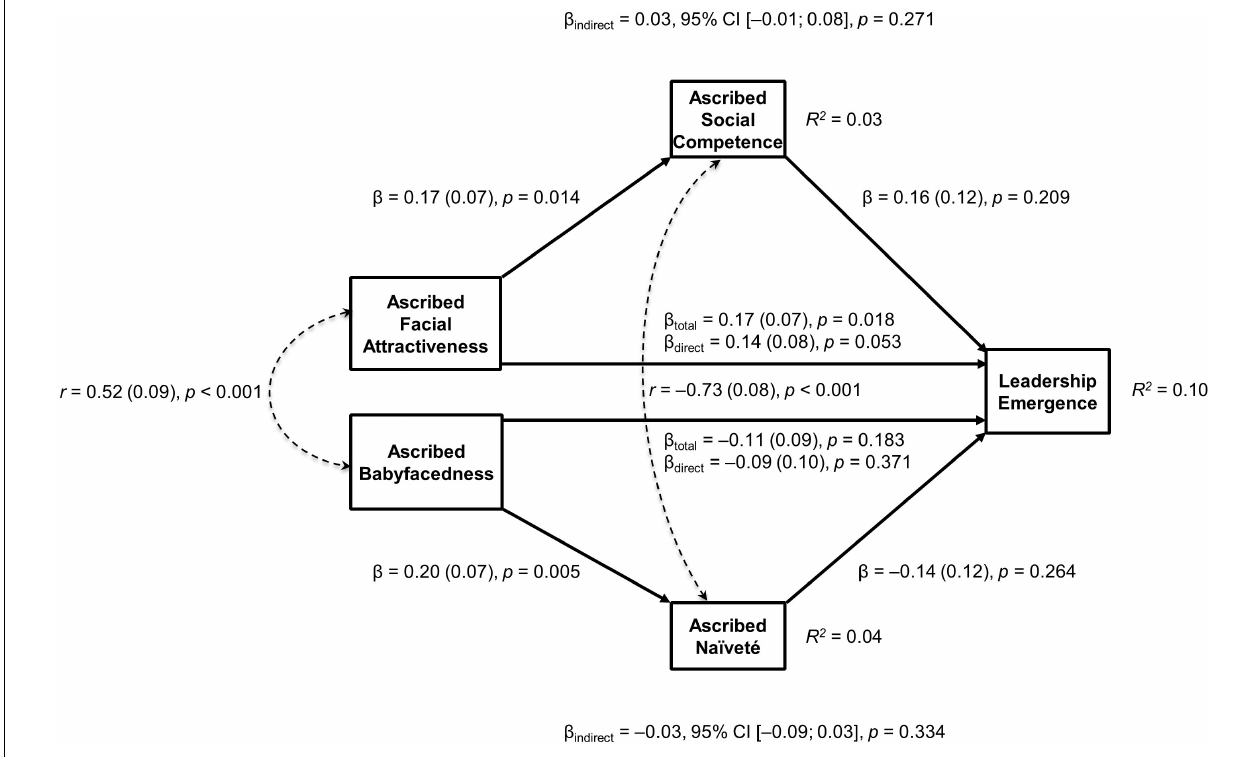
FIGURE 3 | Testing both mediation hypotheses in one path model [ χ 2 (2, N = 188) = 0.43, CFI = 1.00, RMSEA < 0.001, SRMR = 0.012] in the main study sample with 1,000 bootstrapping samples. β (standard error) values represent standardized regression coefficients. total = unique total effect. direct = unique direct effect. indirect = unique indirect effect. Unique indirect effects were not significant for both paths ascribed attractiveness – ascribed social competence – leadership emergence as well as for ascribed babyfacedness – ascribed naïveté – leadership